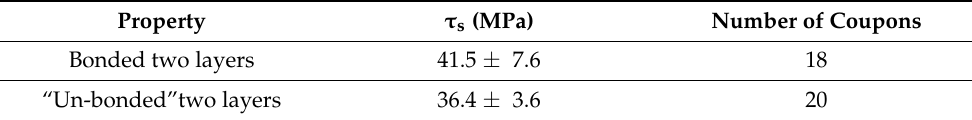
Figure 20. Macroscopic fracture modes in shear loading of holed coupons; ( a ) delamination cracks at the V-notch; ( b ) cracks occurring as a result of further loading at 5.5 mm holed coupon. Table 7. Shear stress of notched coupons in the presence of various